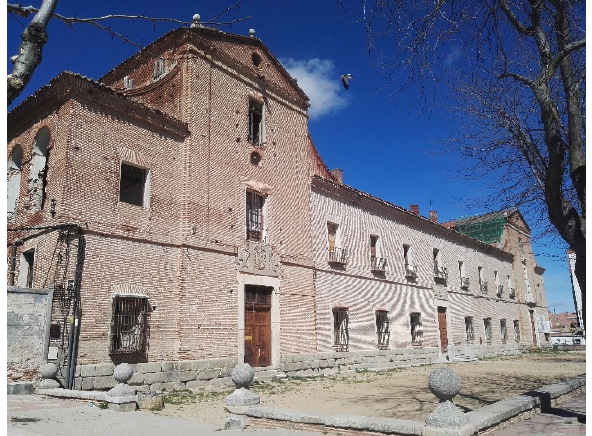
Figure 2: Simón Ruiz Hospital on Avenida